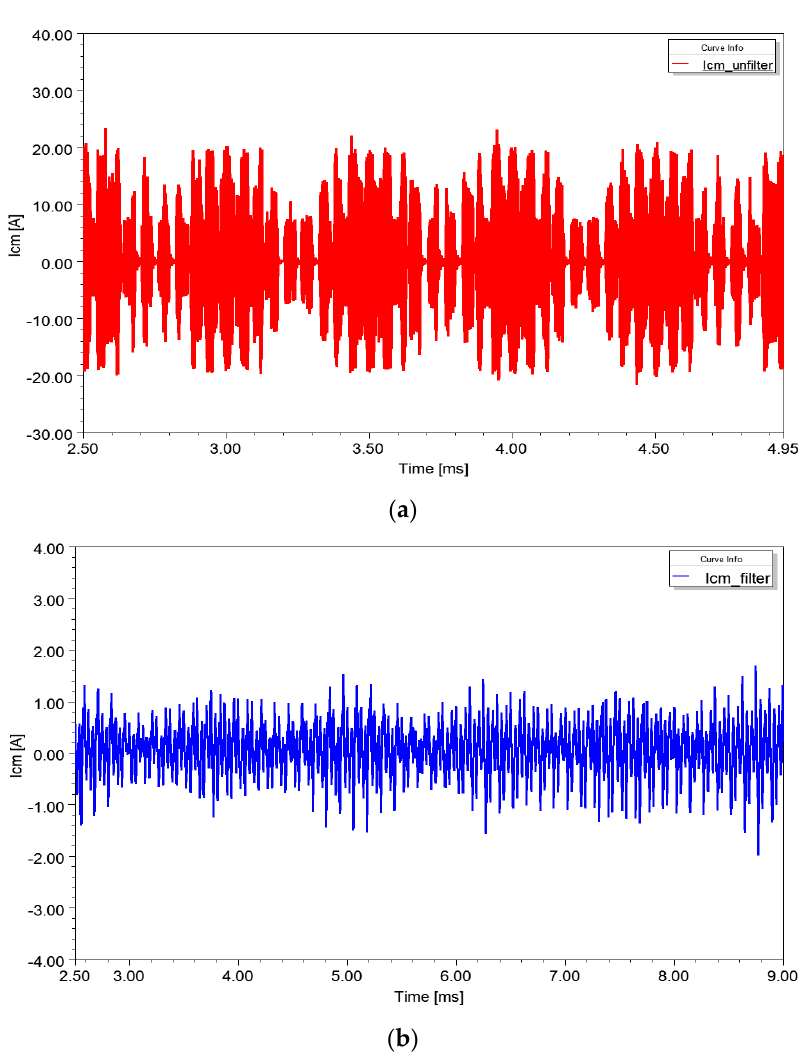
Figure 4. The common mode current: ( a ) without filtering; ( b ) with filtering circuit.